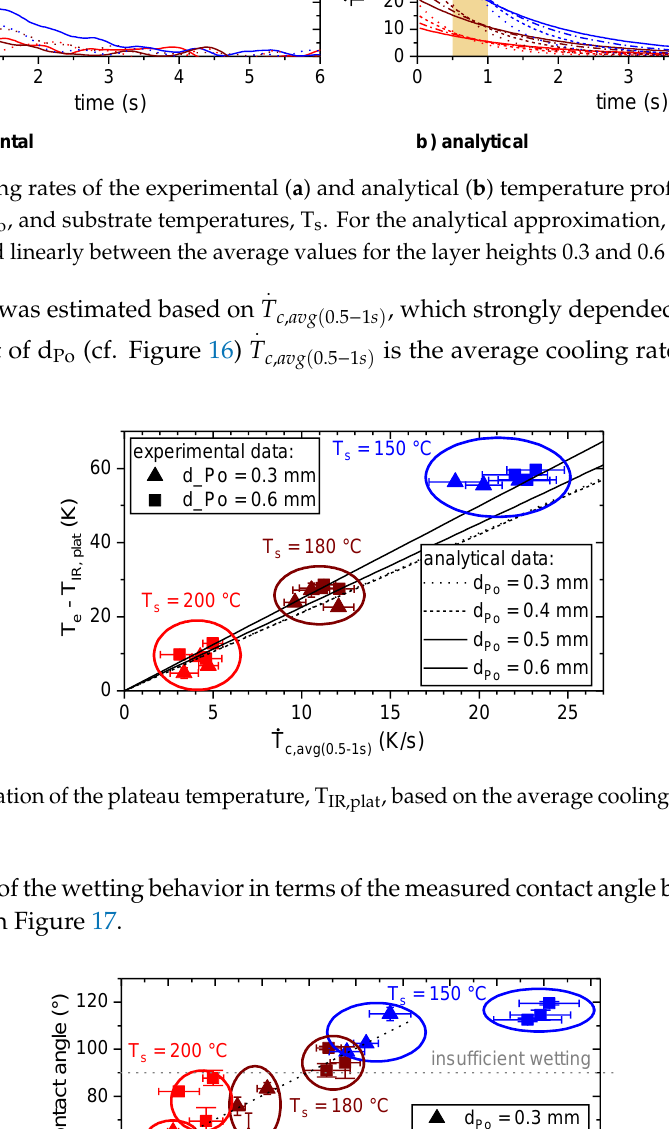
Figure 17. Contact angle as a function of the average cooling rate, 𝑇̇ 𝑐,𝑎𝑣𝑔(0.5−1𝑠) , and the preset contact angle, φ cs,i , (cf. Equation (4)).